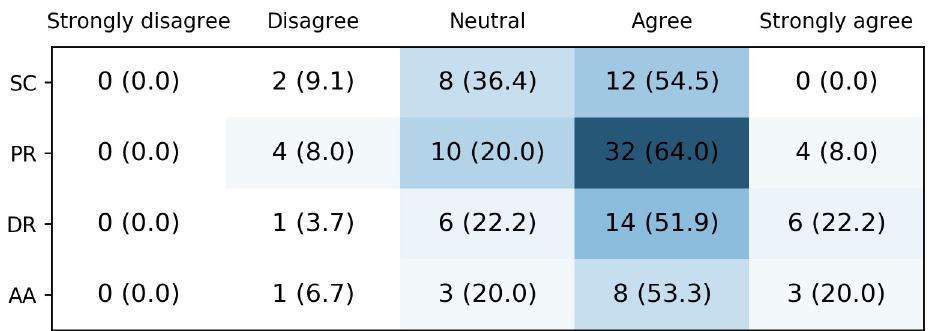
Fig 9. Healthcare providers’ perceived sufficiency of the received training on the different CDS tools. SC: Safety Code cards, PR: printed reports, DR: digital reports, AA: automatic alerts.